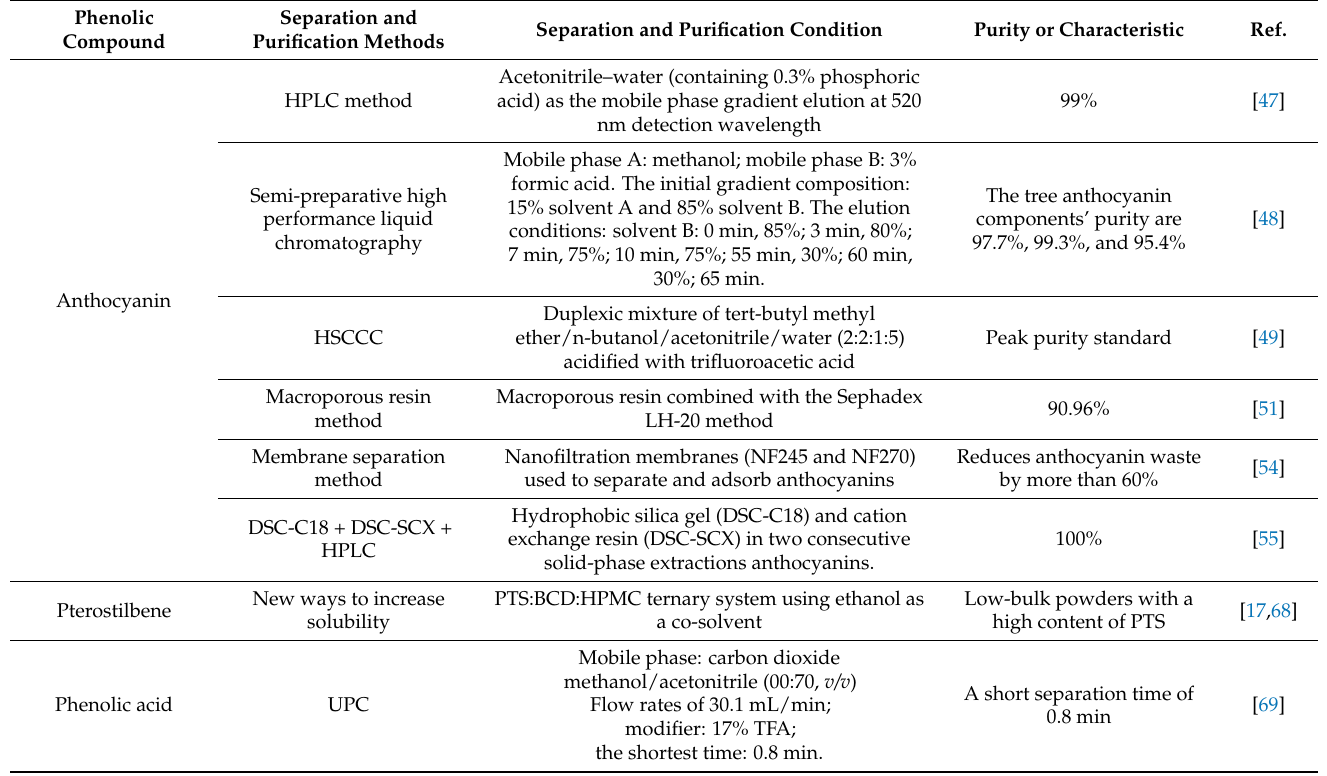
Table 2. The separation and purification methods of phenolic compounds from blueberries are summarized in this